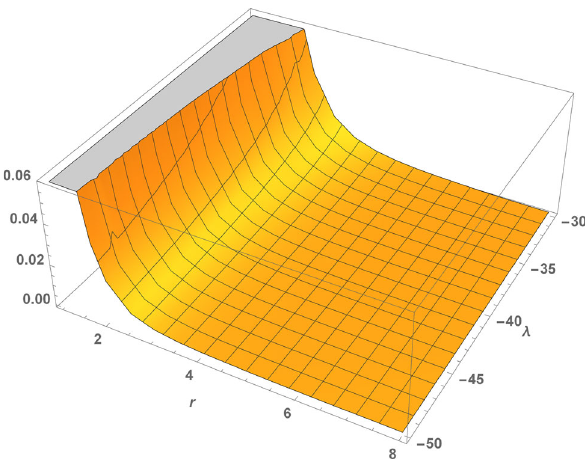
Fig. 4 Validity of NEC, ρ + p r ≥ 0, for λ = − 35 and different α